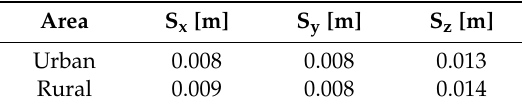
Table 4. Standard deviations of the coordinates of the GCPs.